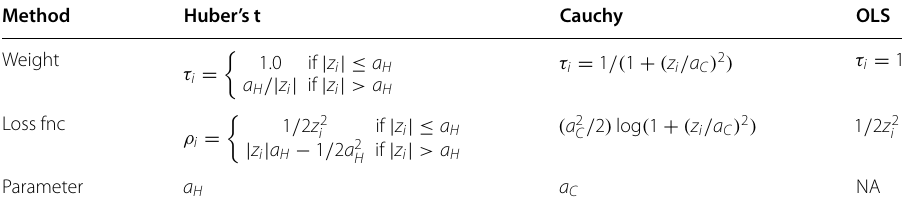
Table 1 Huber, Cauchy and OLS loss and weight functions Method Huber’s t Cauchy OLS Weight τ i = (cid:31)